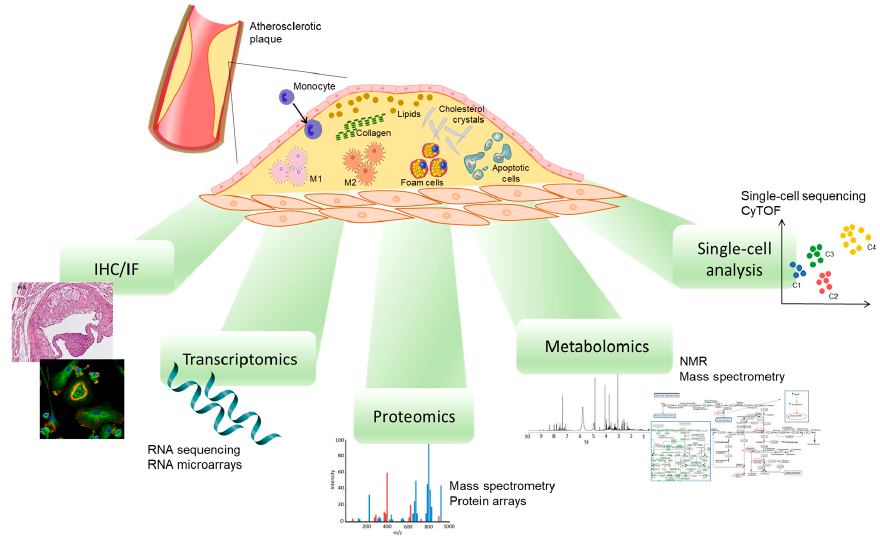
Figure 2. Different techniques to study macrophage phenotypes. IHC/IF, immunohistochemistry/immunofluorescence; NMR, nuclear magnetic resonance; CyTOF, cytometry by time of flight.